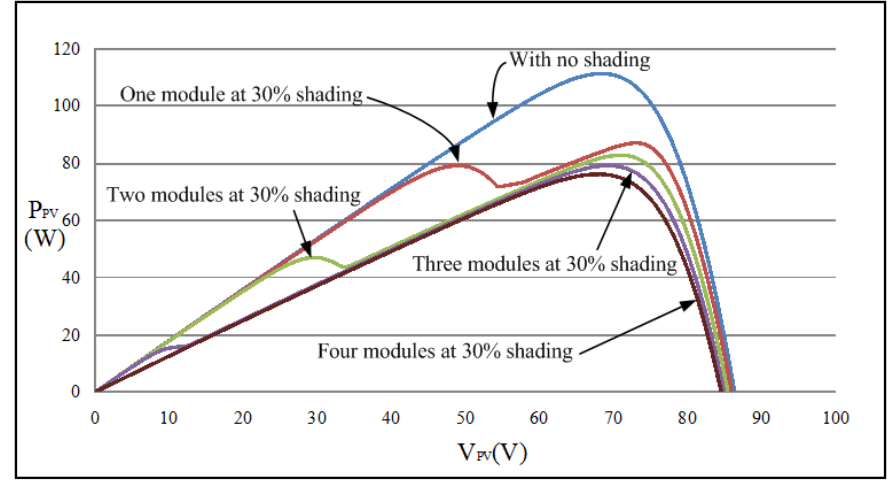
Figure 2. Simulated P–V characteristic curves of the four-serial and one-parallel array with different numbers of modules under 30% shading.